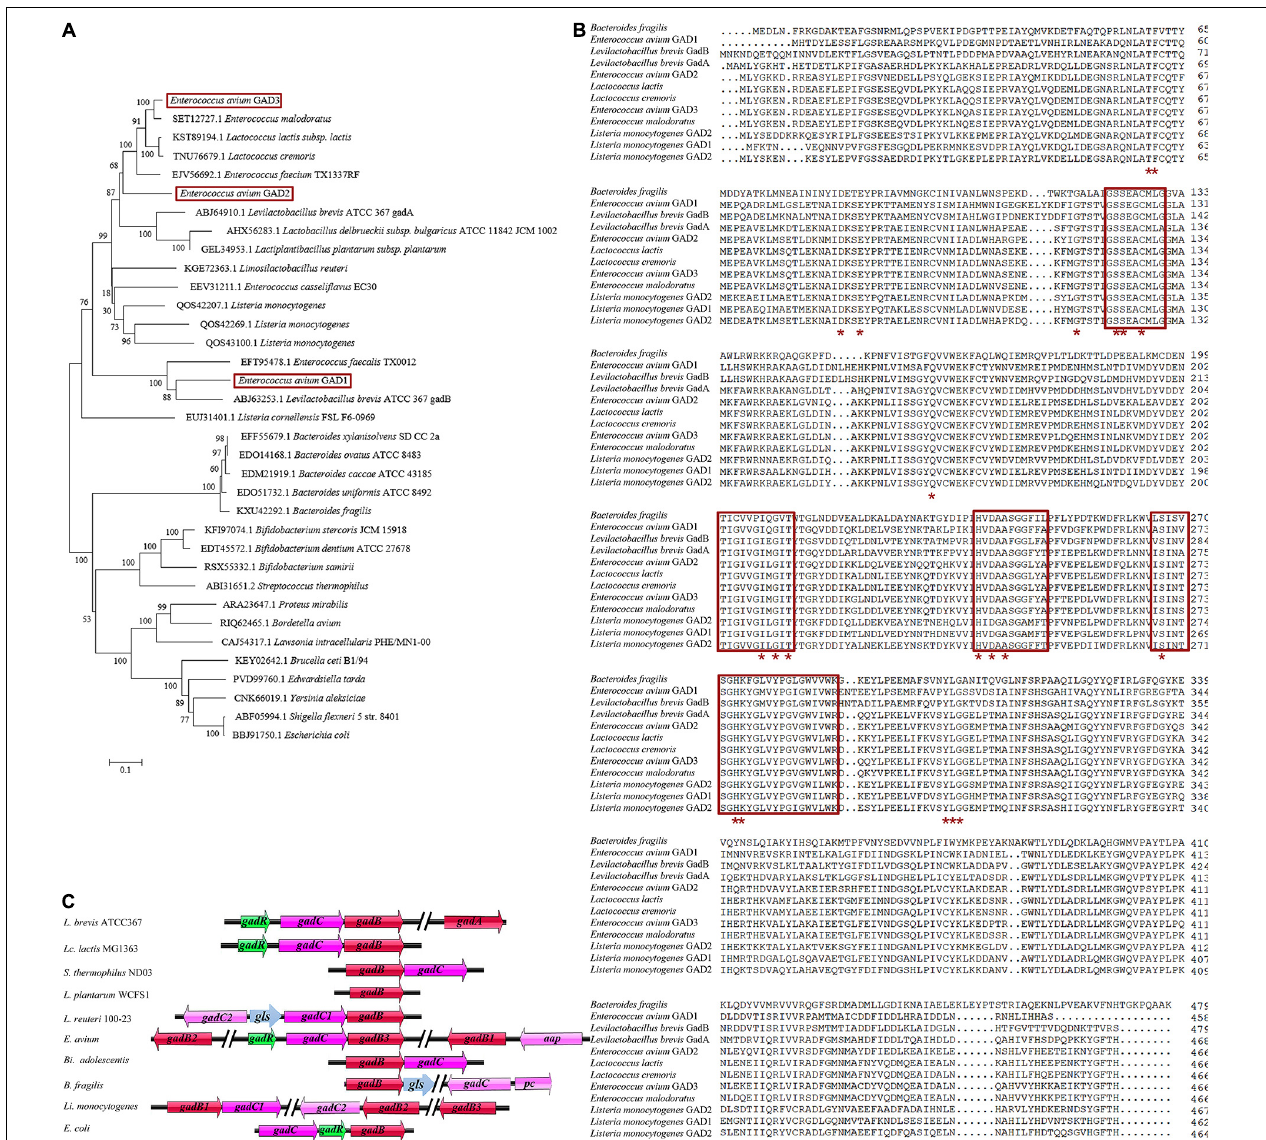
FIGURE 1 | Genetic organization of the glutamate decarboxylase (GAD) system in E. avium . (A) Phylogenetic tree (maximum-likelihood method) based on the amino acid sequences of GADs from E. avium and other GABA-producing species. The GenBank accession numbers of GADs from each strain were indicated. (B) Amino acid sequence alignment of three GADs from E. avium and other GABA-producing species. The PLP-binding domain was indicated by the red box. The active site residues were marked by the red asterisk. (C) Representations of the GAD system in E. avium and other GABA-producing species. The gls gene encoded glutaminase; the pc gene encoded potassium channel; and the aap gene encoded amino acid permease, Na/Pi cotransporter, or extra glutamate/GABA